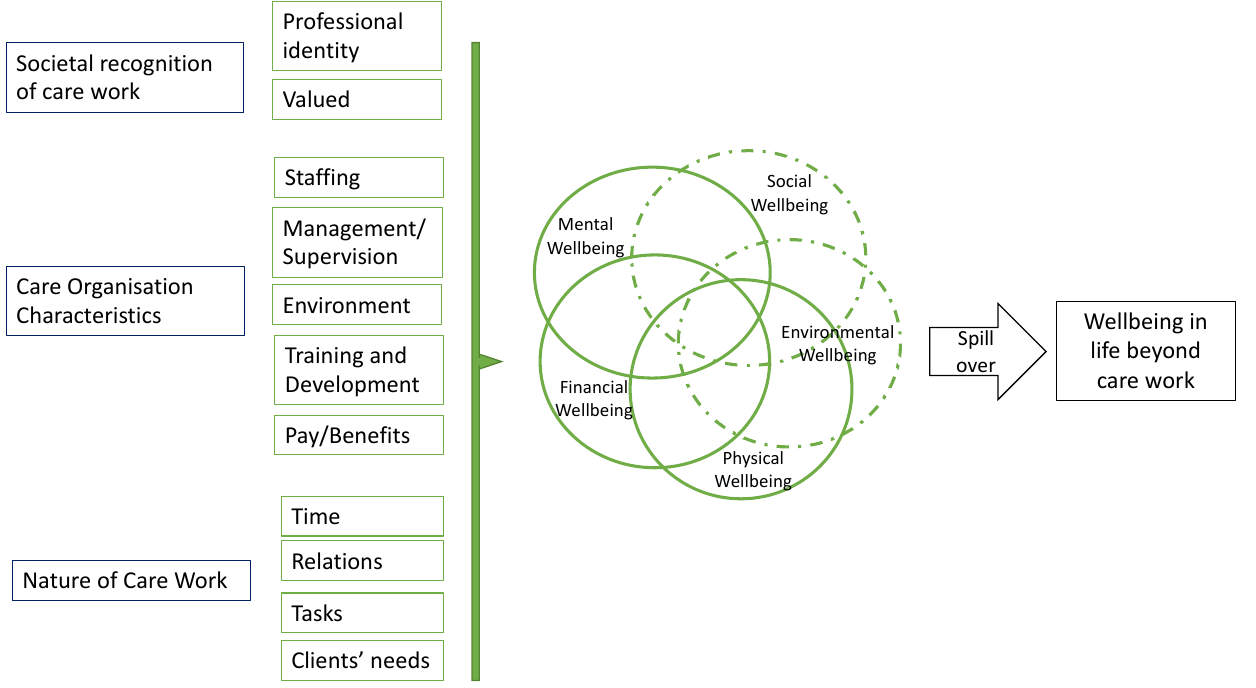
Figure 3. Care Work Related Quality of Life (CWRQoL): a theoretical model.